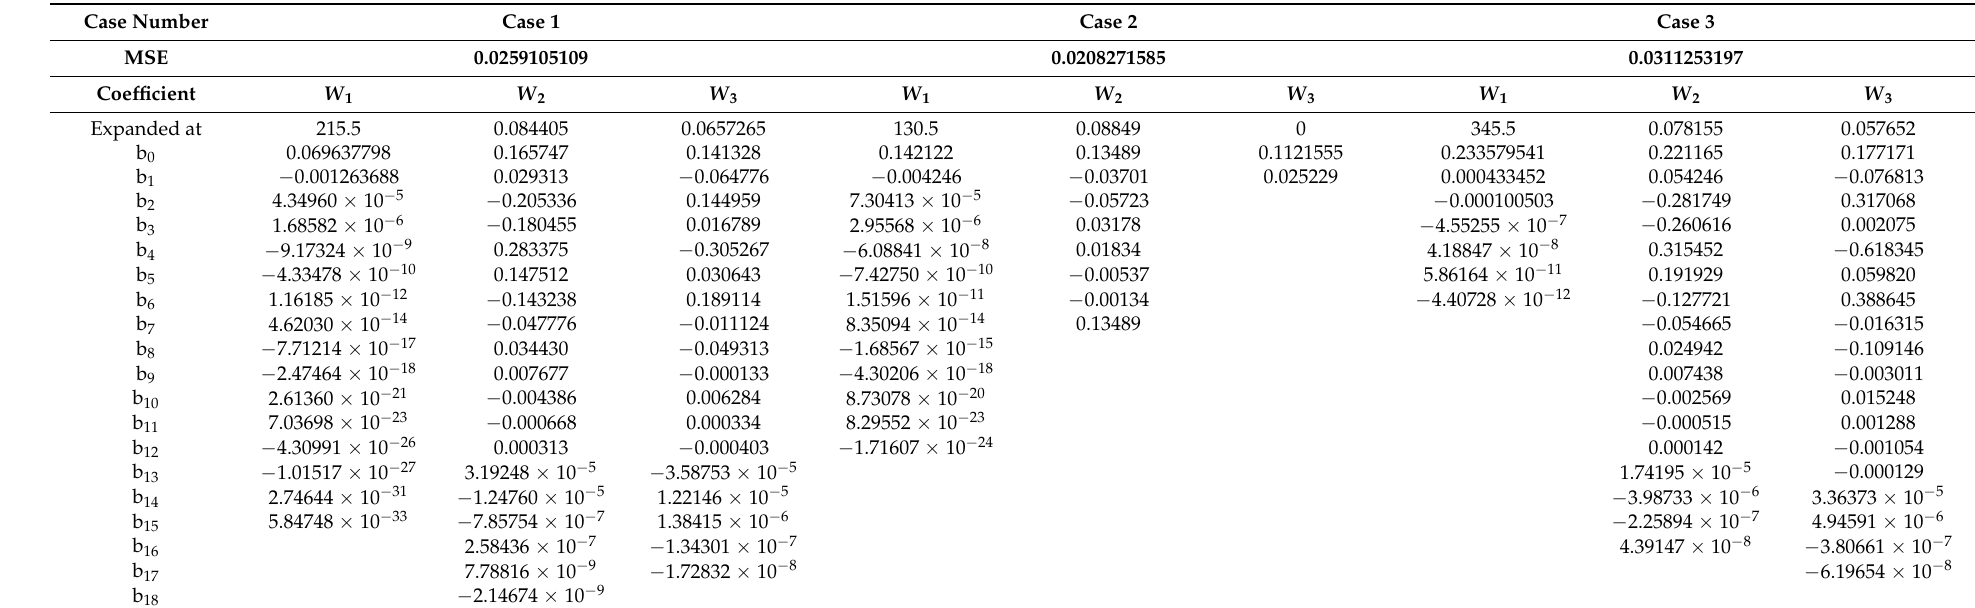
Table 3. Coefficients of curvilinear for each explanatory variable at each